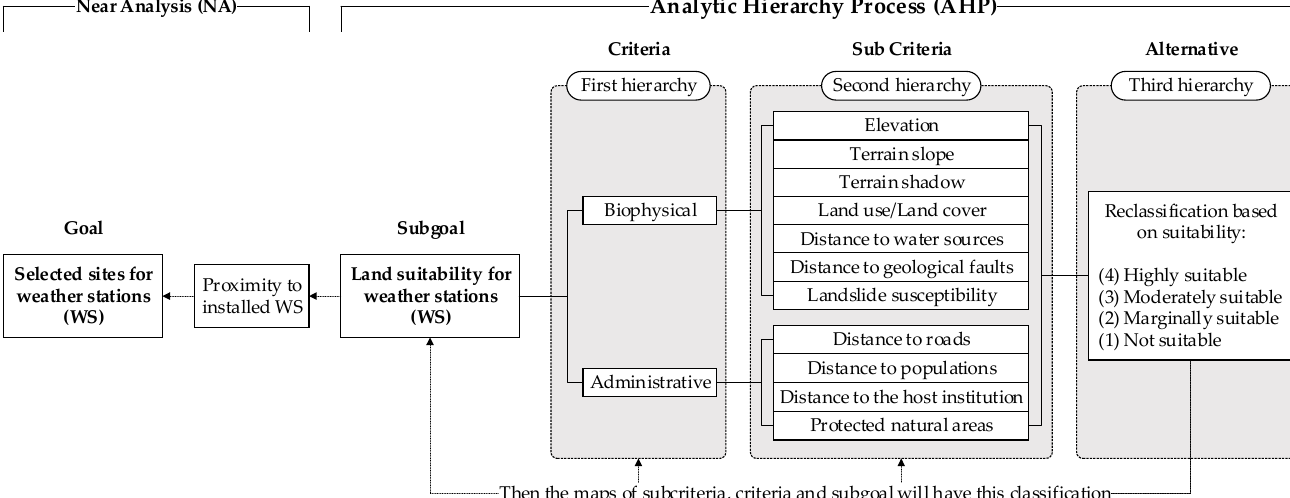
Table 1. Sub criteria scoring for selecting weather station sites in Amazonas, NW Peru. Criteria/Sub-Criteria